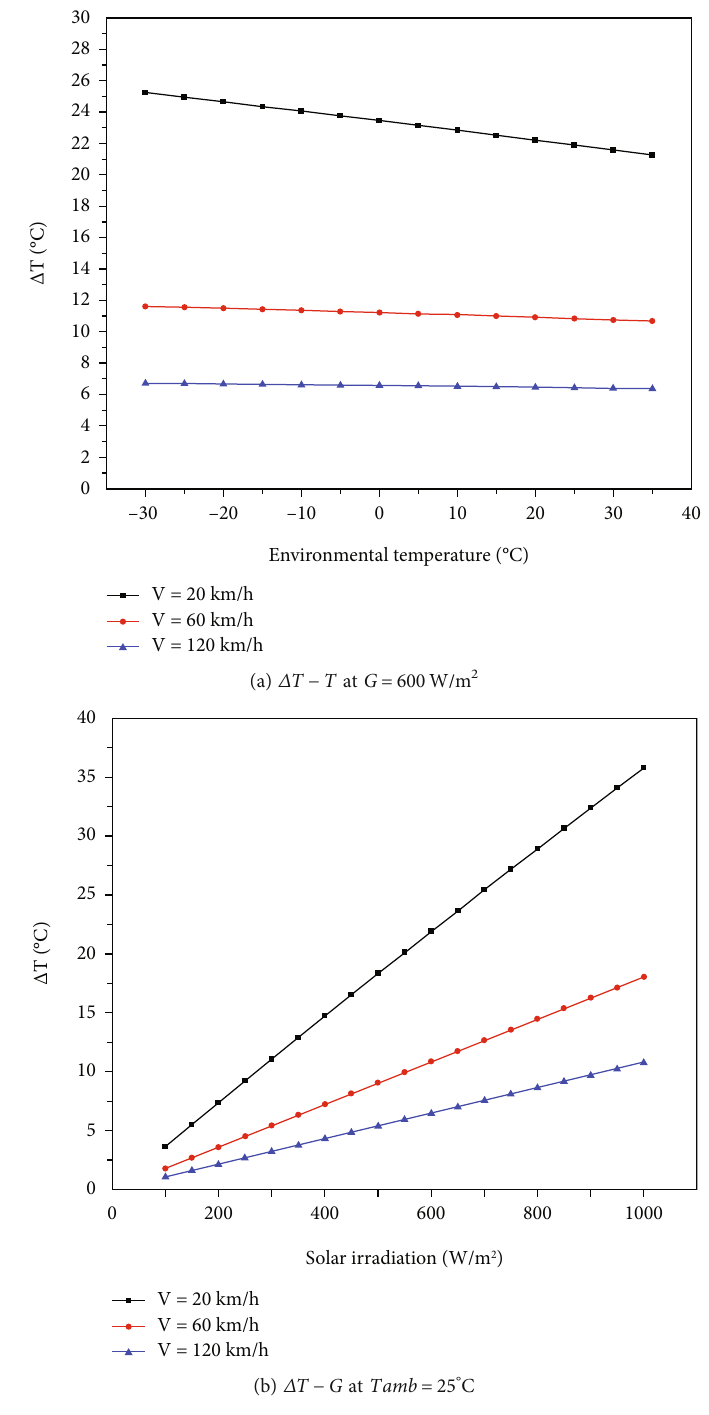
Figure 13: Curve for Δ T − T and Δ T − G